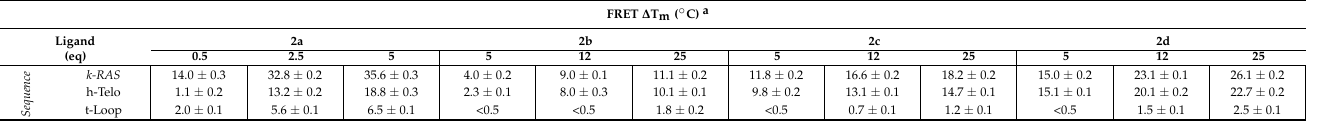
Table 2. Melting temperature variations ( ∆ T m ) values for the tested sequences in the presence of the methylated dicarbox- amide derivatives, obtained by FRET-melting assay.